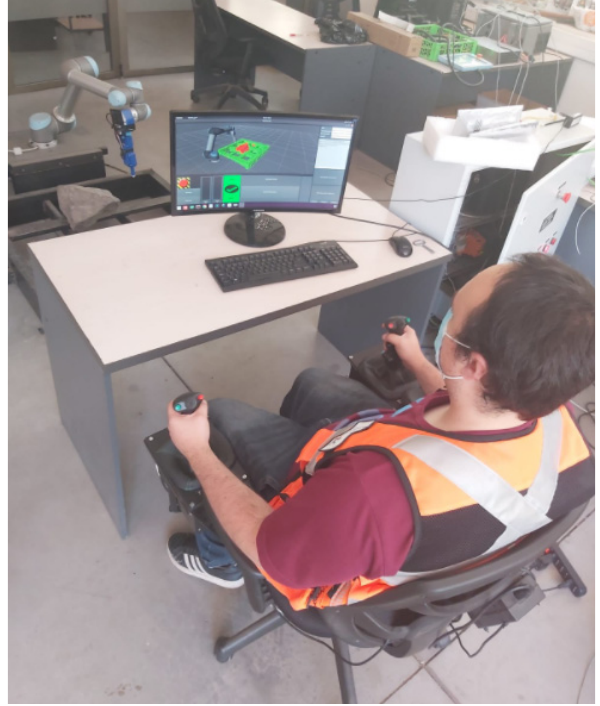
Figure 17. User operating the UR5 arm, using the haptic controls (installed on a chair), and the user interface.